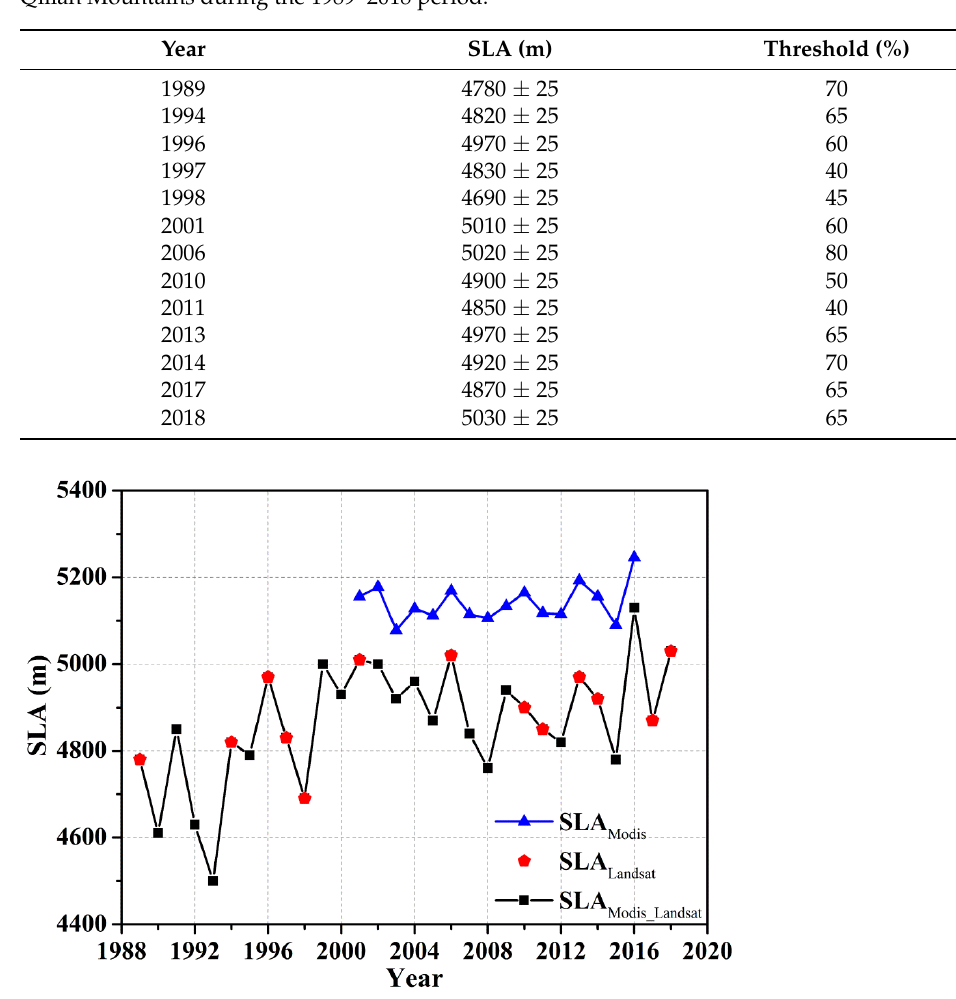
Figure 3. Glacier SLA obtained by using Landsat data and MODIS data, and SLA sequence of Qiyi Glacier in Qilian Mountains from 1989 to 2018 extracted by using Landsat data as the “ reference value” assisted by MODIS data.